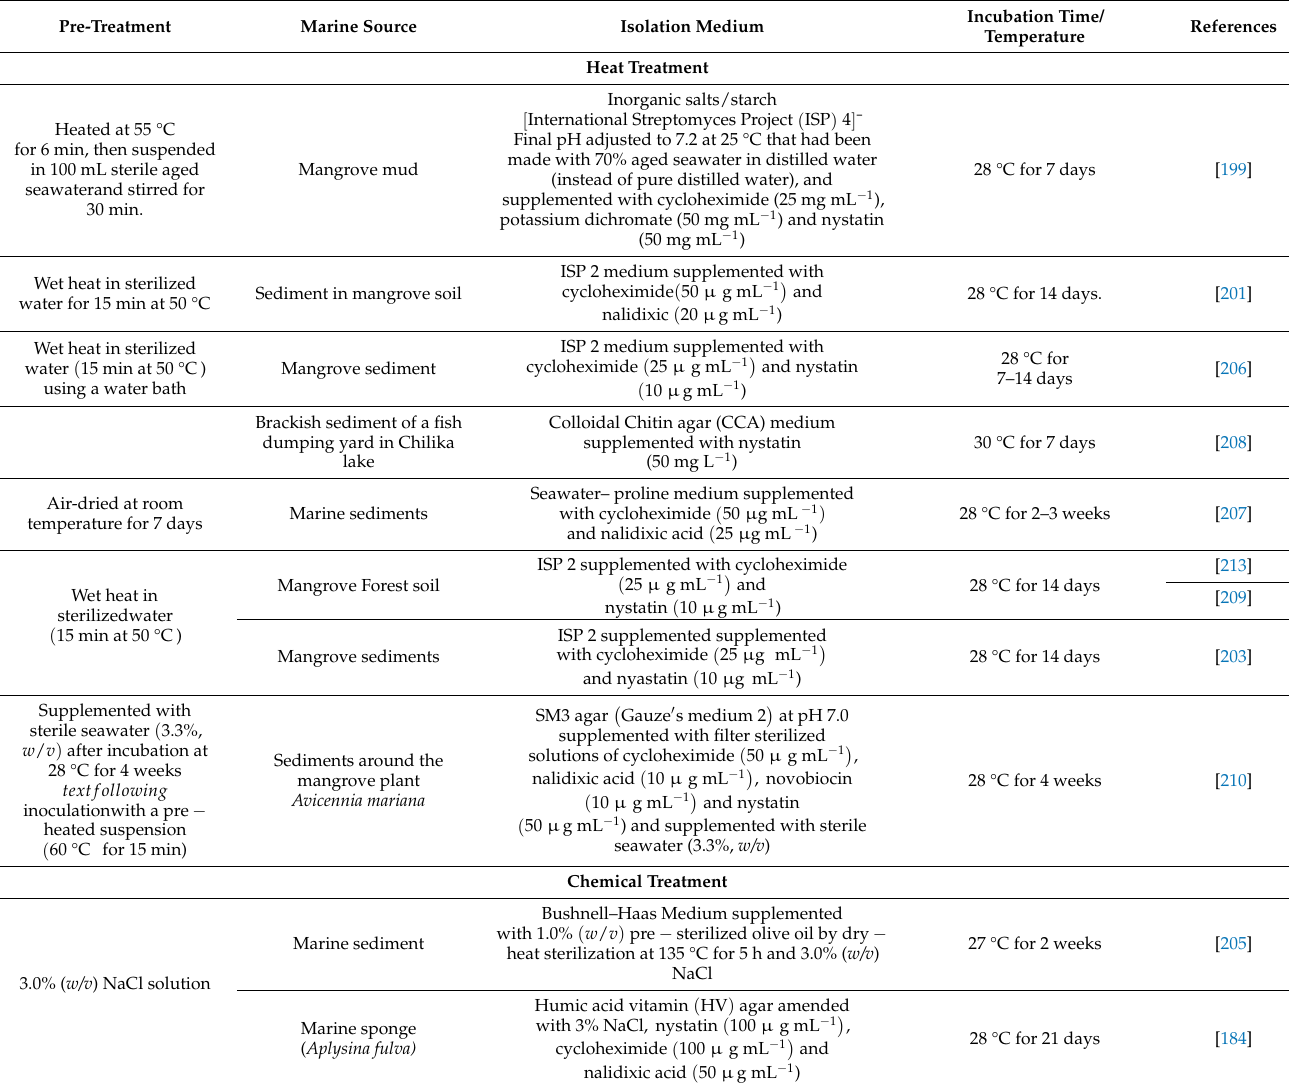
Table 8. Pretreatment Method for isolation of novel Streptomyces spp. From marine sources between